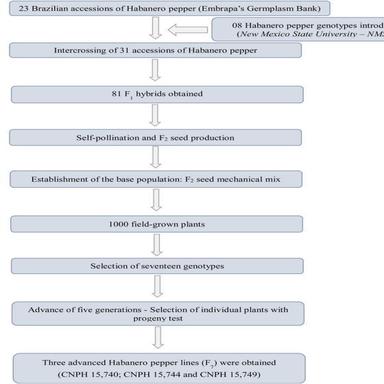
Genealogy of Embrapa Vegetable's Capsicum breeding program to obtain three advanced Habanero pepper lines.